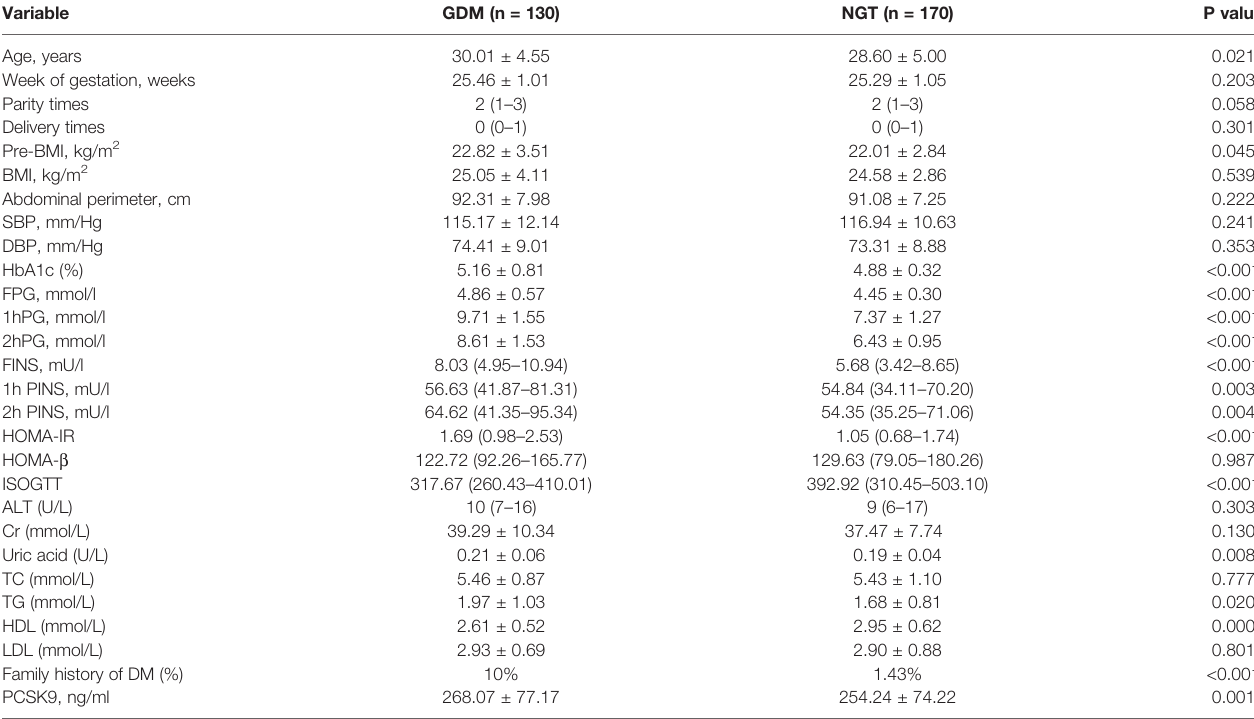
TABLE 1 | Clinical characteristics and circulating PCSK9 level of the groups studied.